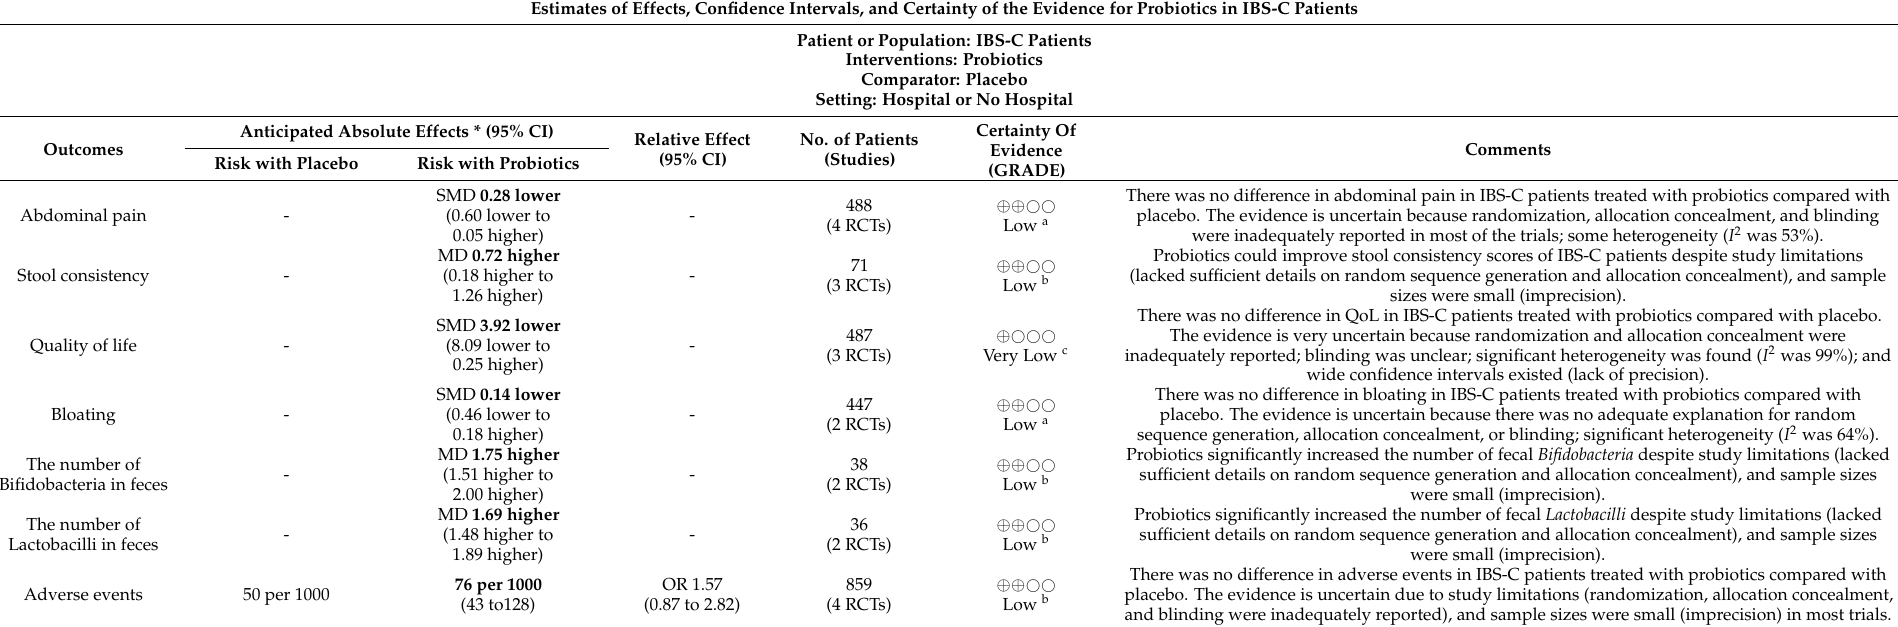
Table 2. Summary of